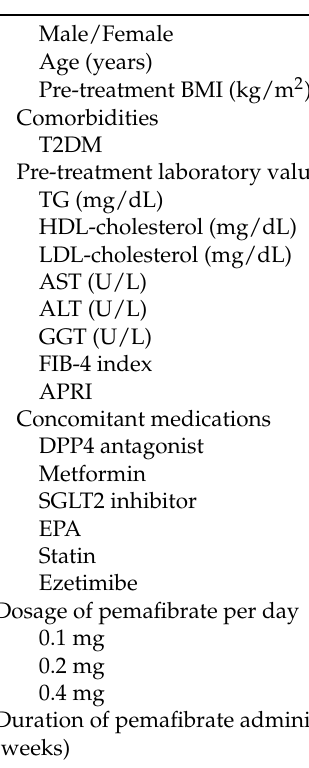
Table 2. Characteristics of the three cases with CT